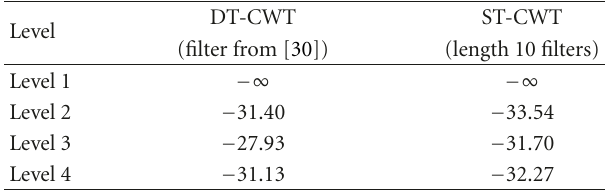
Table 2: Aliasing energy ratio in